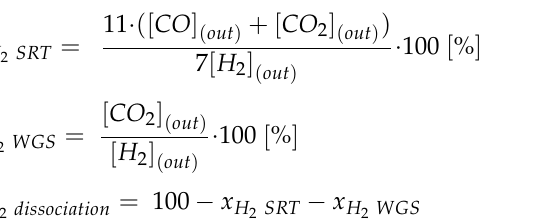
Figure 9. The contribution of H 2 produced in the SRT reaction ( a ), the WGS reaction ( b ) and the H 2 O decomposition reaction ( c ) during the catalytic tests of toluene steam reforming carried out at S/C = 1 (green), 1.2 (purple), 2.4 (red), and 4 (blue), with contact time (t c ) varying from 0.003 to 0.36 s (the darker the shade of the bar the higher the t c value).